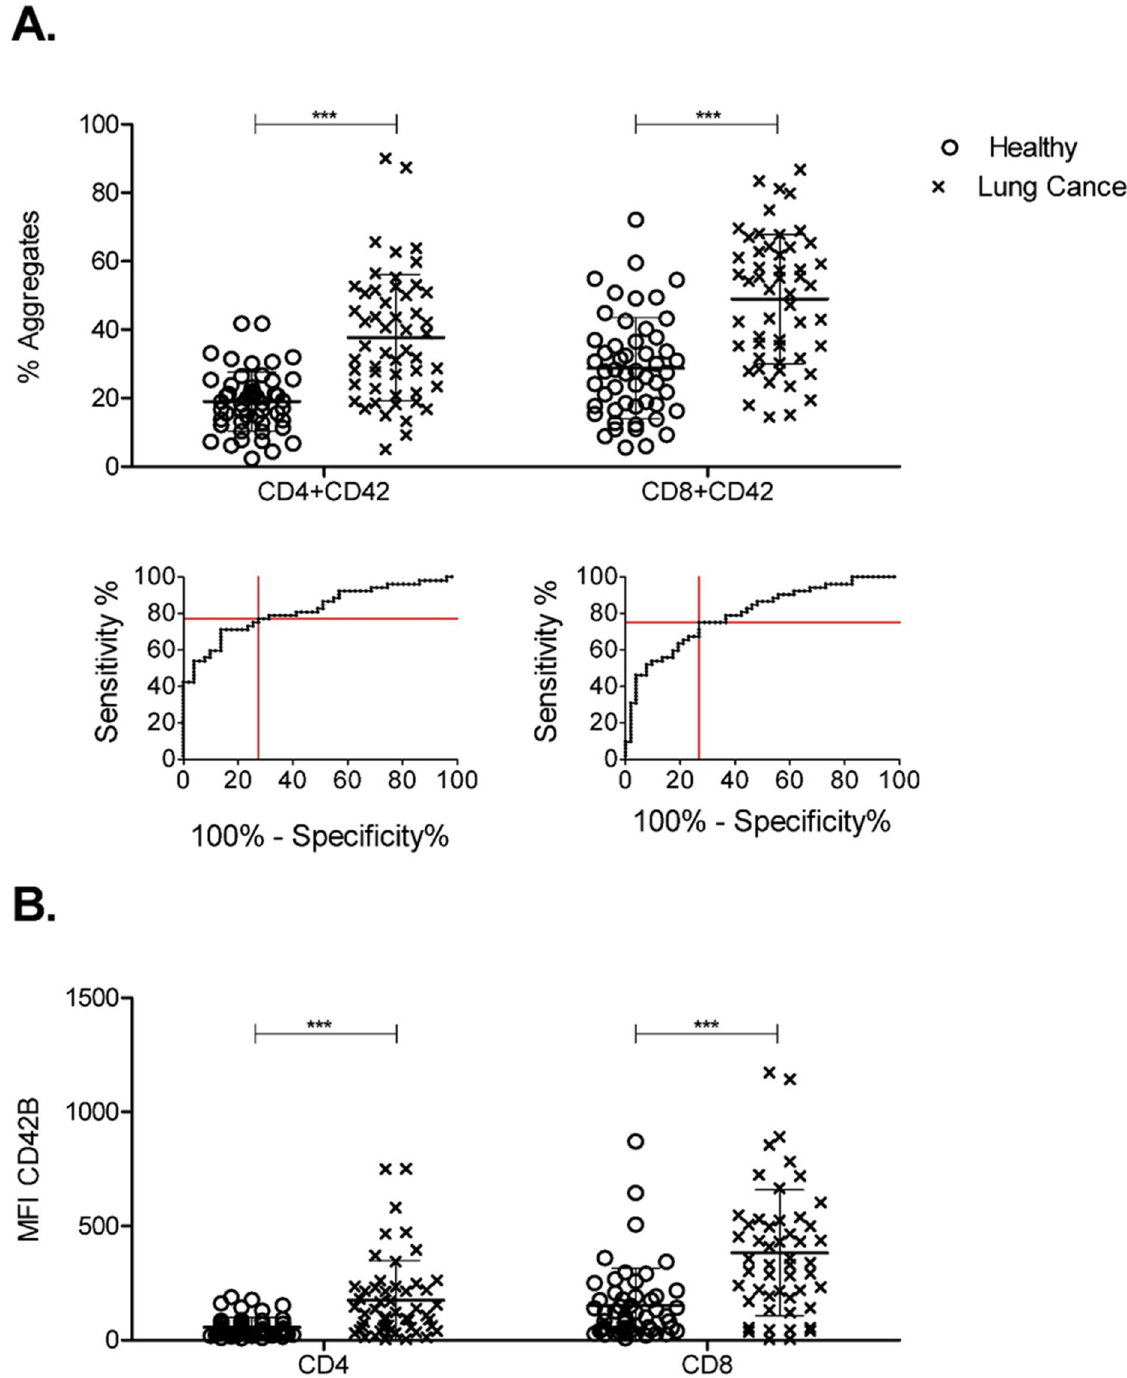
Fig 2. Frequency and size of platelet-T cell aggregates in lung cancer patients compared to healthy volunteers. Whole blood from healthy volunteers or lung cancer patients was labeled with markers for CD4+ T cells (anti-CD4) or CD8+ T cells (anti-CD8) and were co-labeled for platelets (anti-CD42b). Data was collected by flow cytometry. Populations were gated based on CD4+ and CD8+. Percent of T cells with a platelet attached (A) and MFI of platelets (B) were calculated using FlowJo software. ROC curves were generated for CD4+ and CD8+ PTCAs for lung cancer patients compared to healthy volunteers. Optimal sensitivity and (1-specificity) were determined using GraphPad Prism and are plotted as red lines. Mann Whitney nonparametric test. Error bars represent mean ± SD. N = 44–52. �� p � 0.01, ��� p � 0.001.